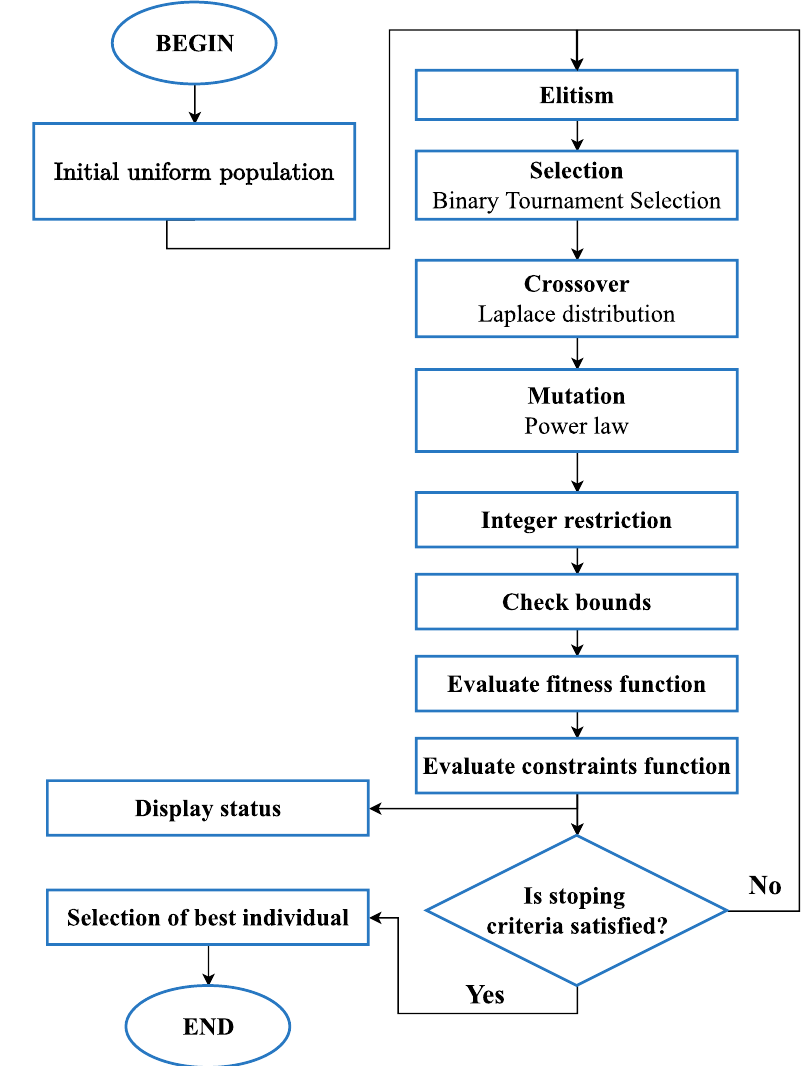
Figure 12. Flowchart of real coded mixed integer genetic